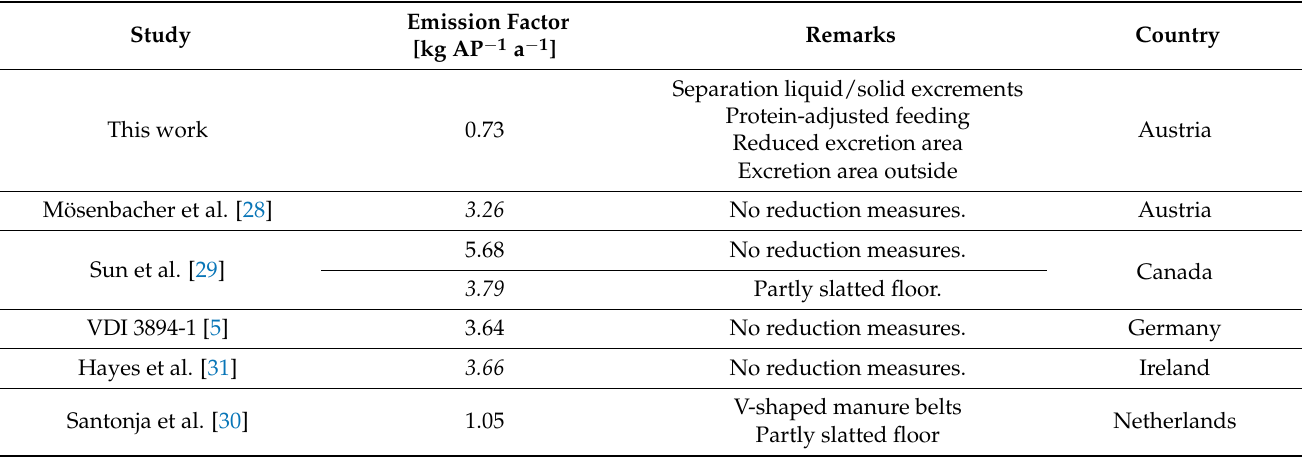
Table 4. Comparison of published emission factors for fattening piggeries in the literature (AP = animal